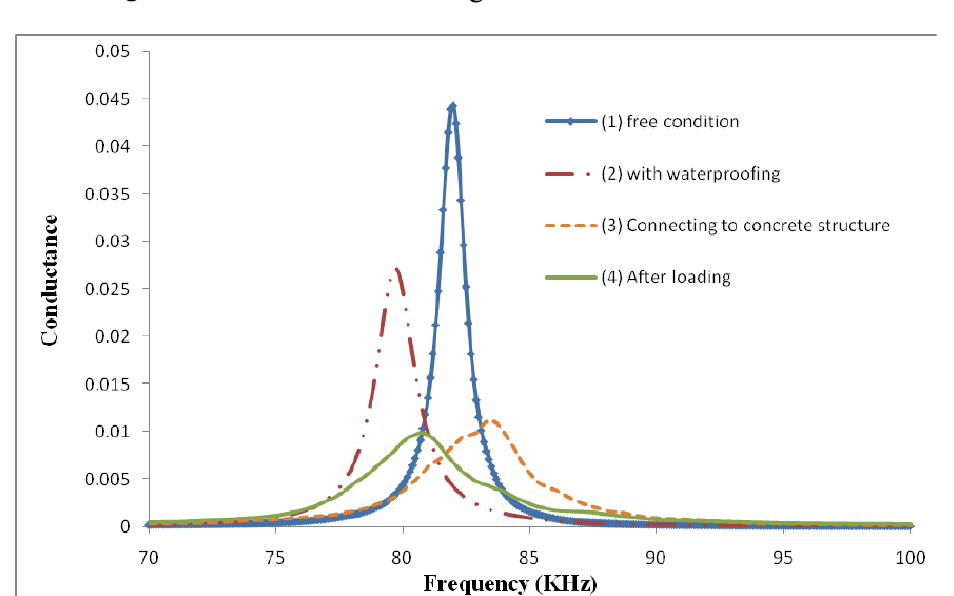
Figure 11. Variation of PZT signatures in different conditions.